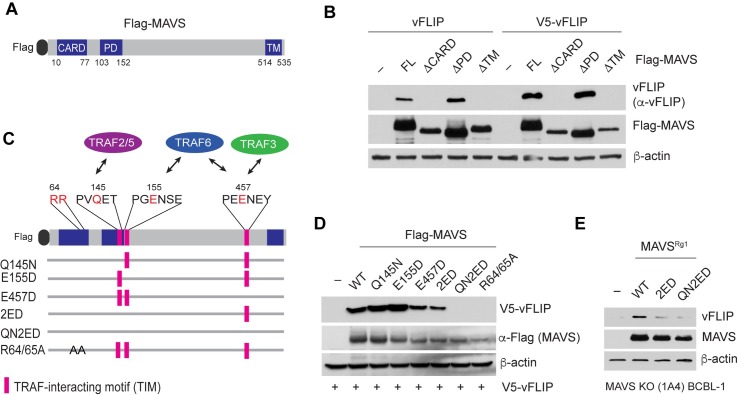
MAVS stabilizes vFLIP via the CARD region and TRAF-interacting motifs.(A) Diagram of Flag-MAVS showing the position of its caspase activation and recruitment domain (CARD), proline-rich domain (PD), and transmembrane (TM) regions. (B) Immunoblots of extracts from 293T cells transfected with Flag-MAVS full-length (FL) and deletion mutants (ΔCARD, ΔPD, and ΔTM) together with non-tag vFLIP or V5-vFLIP. (C) Diagram of MAVS mutations of the CARD and TRAF-interacting motifs (TIMs). (D) Immunoblots of extracts from 293T cells transfected with Flag-MAVS WT and point mutants together with V5-vFLIP. (E) Immunoblots of extracts from BCBL-1 MAVS KO (1A4) cells lentivirally transduced with WT and mutants (2ED and QN2ED) of MAVS (MAVSRg1) resistant to the MAVS gRNA1.